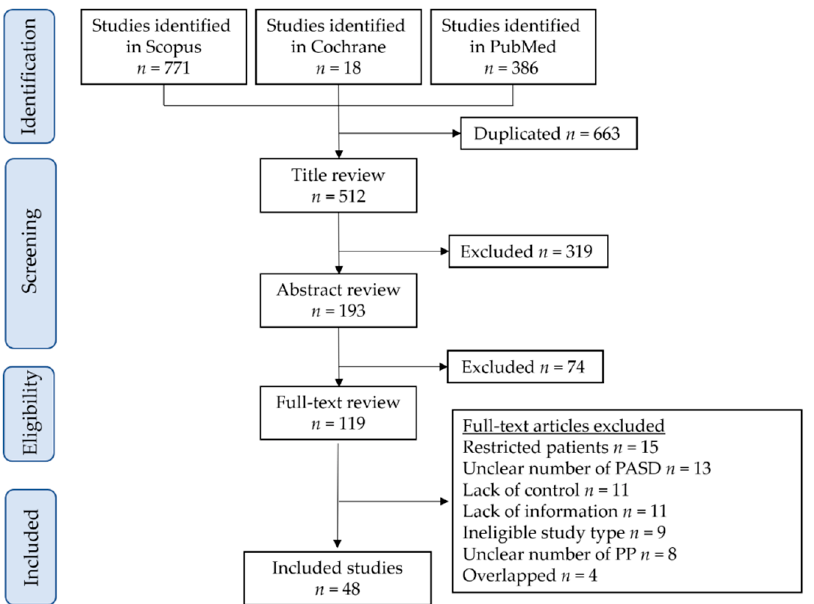
Figure 1. Study selection scheme of the systematic search of articles. Abbreviations: PP, placenta previa, PASD, placenta accreta spectrum disorder.